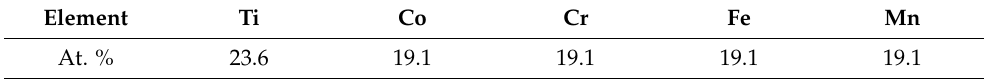
Table 1. Chemical composition of the high-entropy alloy in question given in atomic percent. Element Ti Co Cr Fe Mn At.